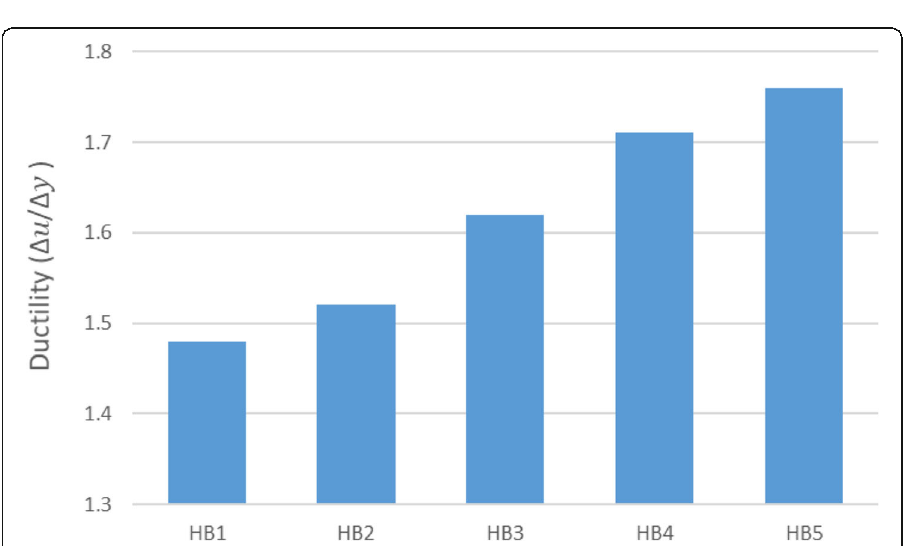
Fig. 14 Ductility of tested shallow wide